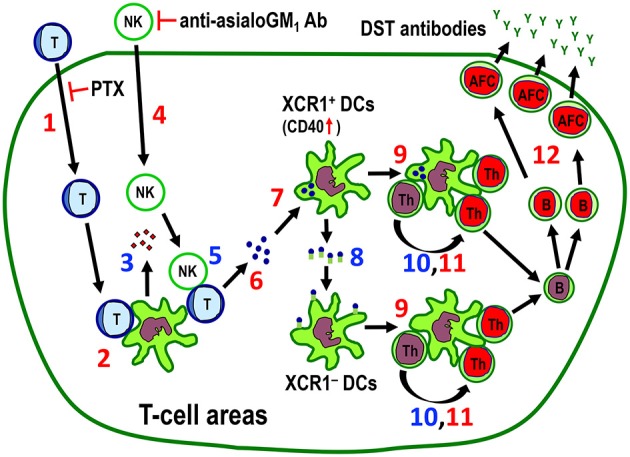
The proposed mechanism for the indirect pathway of allorecognition in the T cell areas of the spleen and LNs. Numbers in red (1, 2, 4, 6, 7, 9, 11, 12) are confirmed findings and those in blue (3, 5, 8, 10) are suggestions. 1. Migration of injected donor T cells to the T cell areas. Pertussis toxin (PTX) inhibits this process. 2. Clustering of donor T cells with recipient DCs. 3. Secretion of NK-recruiting chemokines by recipient DCs. 4. Recruitment of NK cells to the T cell areas. Anti-asialo GM1 antibody (Ab) inhibits this process. 5. Killing of donor T cells by NK cells. 6. Fragmentation of T cells in the T cell area. 7. Phagocytosis of donor T cell fragments by XCR1+ DCs, which was associated with upregulation of CD40 in these cells. 8. Transfer of captured antigenic information by XCR1+ DCs to resident XCR1− DCs in the T cell areas. 9. Cluster formation of both XCR1+CD103+ and XCR1−CD103+ DCs in the T cell area. 10. Presentation of donor MHCI peptides to CD4+ T cells. 11. Proliferative response of CD4+ T cells in the cluster (24). 12. Antibody-forming cell response with production and secretion of donor-specific transfusion (DST) antibodies (24). Blue cells and green cells are donor and recipient cells, respectively. Red nuclei indicate proliferating cells. AFC, antibody-forming cell; Th, CD4+ T cell.